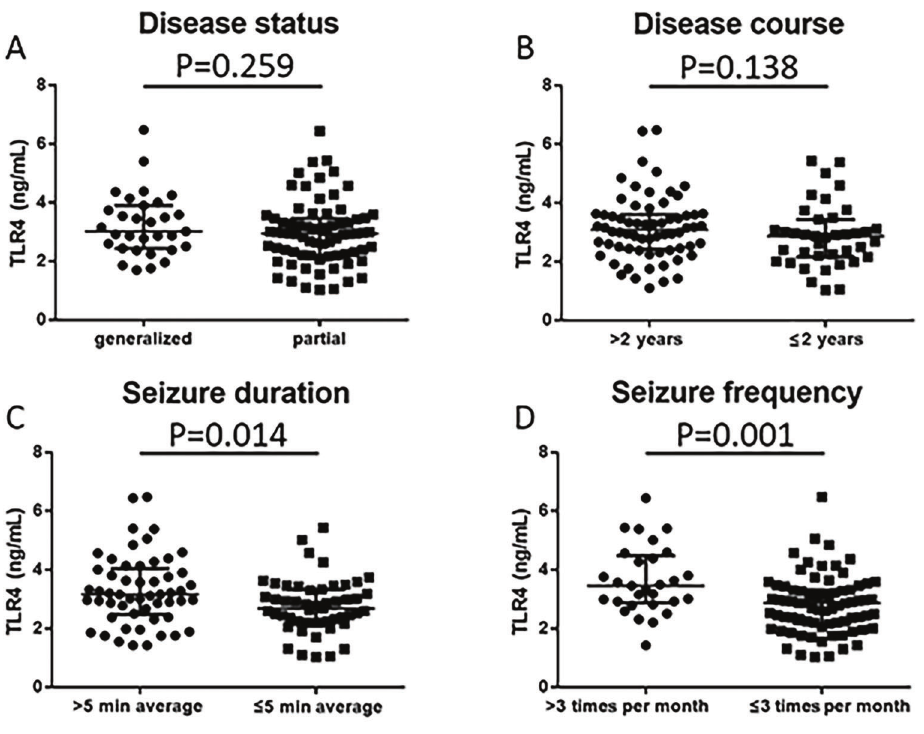
Figure 5 . Comparison of toll-like receptor 4 (TLR4) between subgroups in epilepsy patients using the Mann-Whitney test. A , Disease status; B , disease course; C , seizure duration; D , seizure